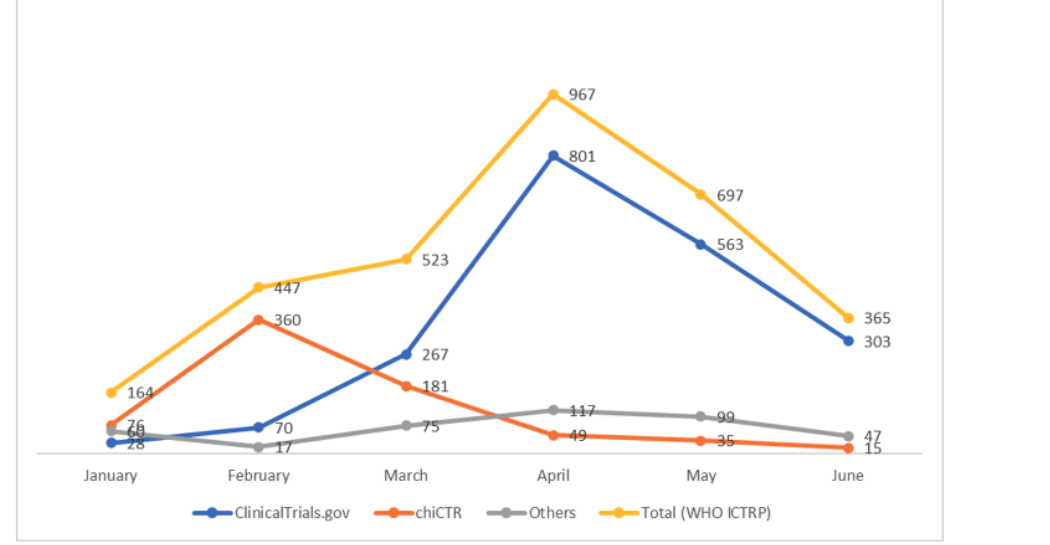
Figure 5. Progression of the number of trials registered in major databases between January and June 2020. chiCTR: Chinese Clinical Trials Registry, WHO ICTRP: World Health Organization International Clinical Trials Registry